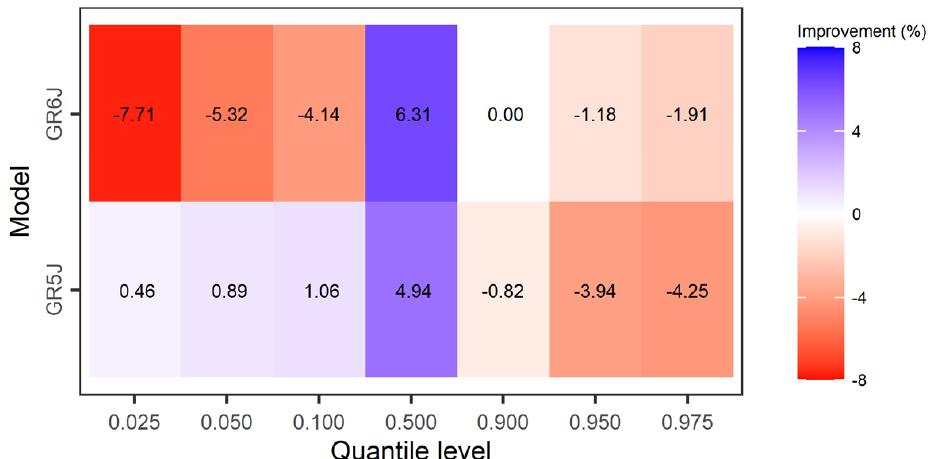
Figure 6. Heatmap of the median of the relative improvements summarizing the results for the 511 river basins of the performance of the GR5J and GR6J models against the performance of the GR4J hydrological model in terms of quantile scores.